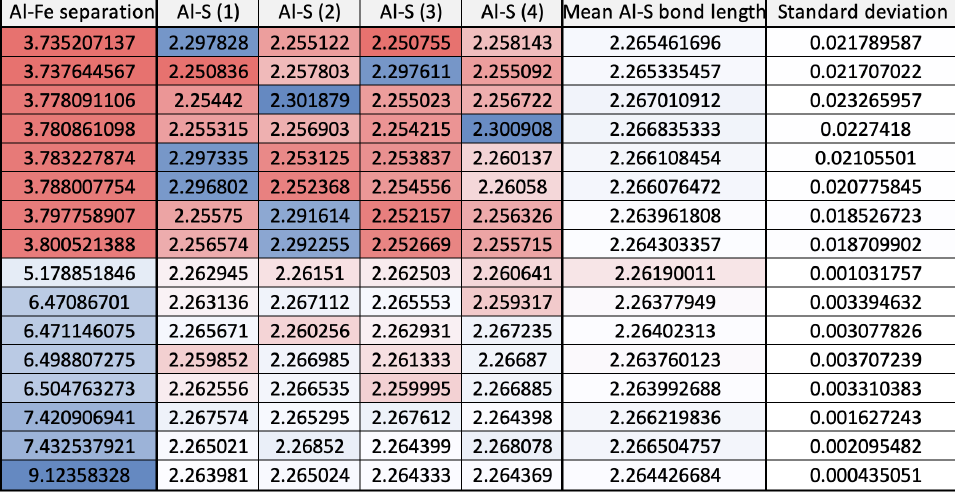
Figure A2. Al-Fe separation and Al-S bond lengths for all Al sites in CuAlS 2 containing an isolated [ Fe ] 2 + antisite defect (blue cells indicate a larger value relative to the mean and red cells indicate a Cu smaller value relative to the